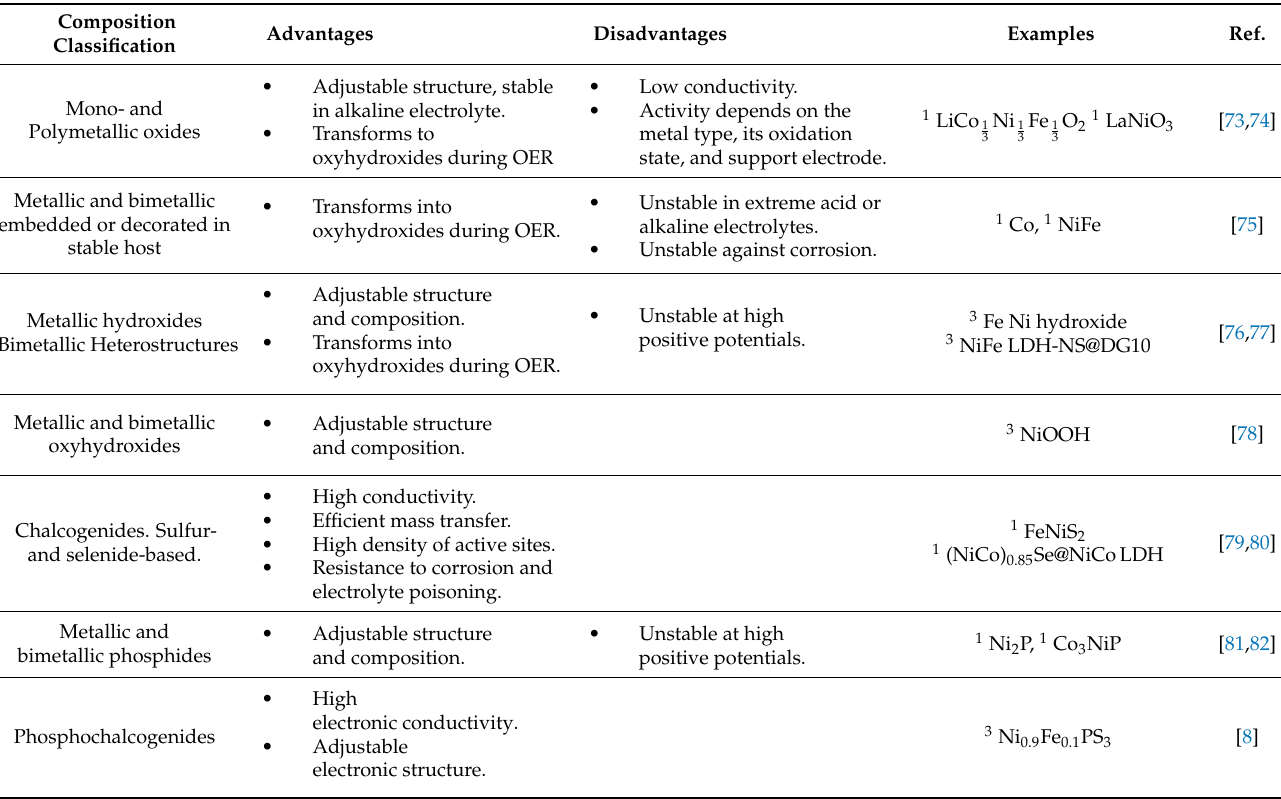
Table 1. Composition of nickel-based alloys reported in the